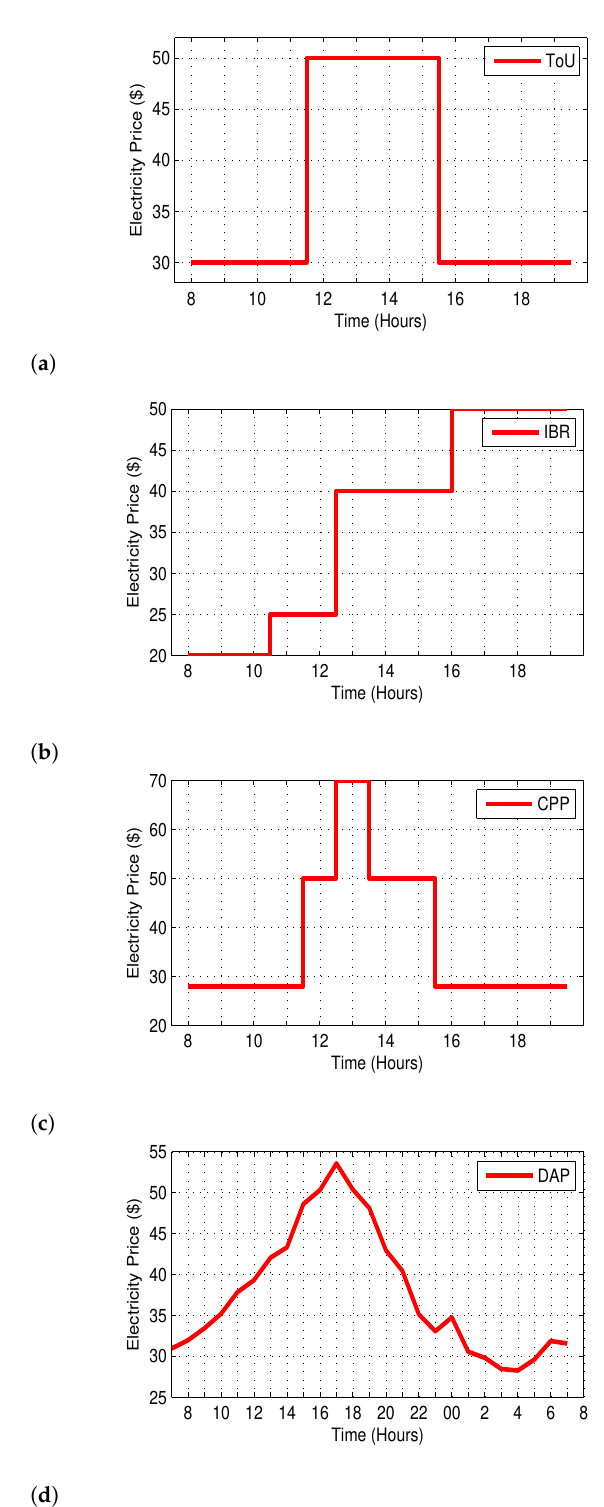
Figure 2. (Different Pricing Signals used in the literature: ( a ) ToU, ( b ) IBR, ( c ) CPP and ( d )